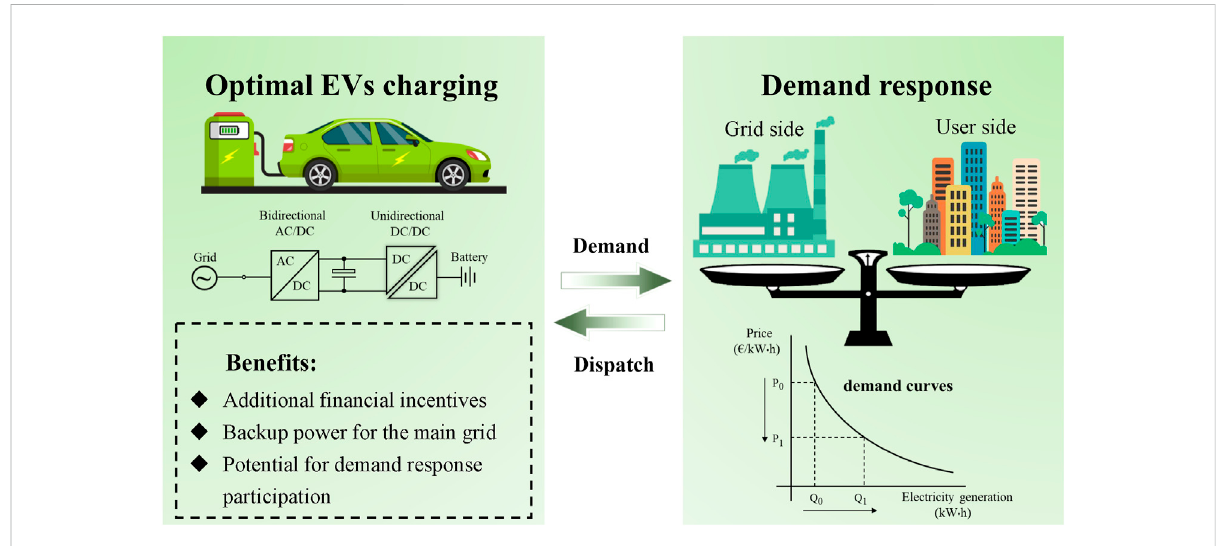
FIGURE 1 Optimal EV charging with demand response and dynamic pricing